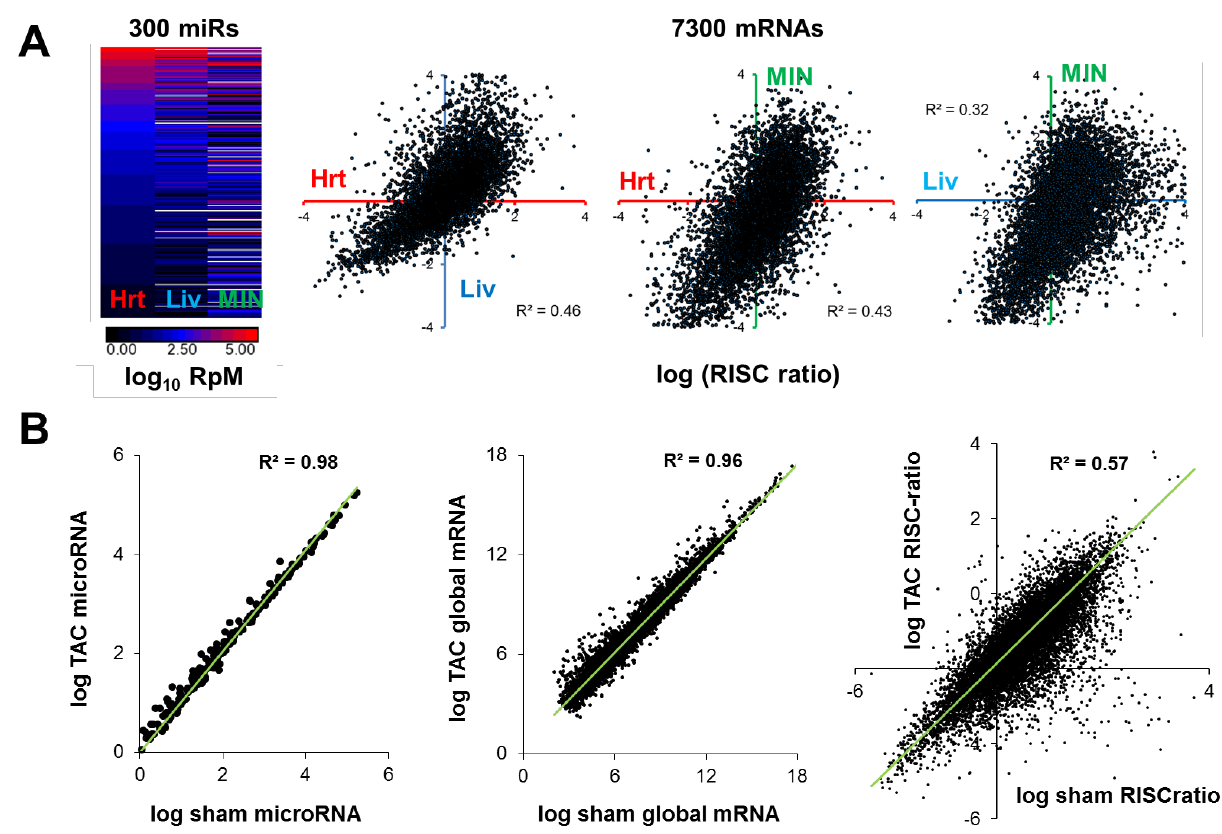
Figure 4. ( a ) Left , Heatmap displaying abundances of 300 microRNAs expressed in mouse heart, liver and MIN-6 cultured  -cells. Right , graphs of log (RISC ratio), where RISC ratio equals (RISC abundance / global mRNA abundance), for 7300 mRNAs expressed in common between heart (red), liver (blue) and  -cells (green). ( b ) Transcriptome-wide differences in microRNAs, global mRNAs, and mRNA RISC ratios in sham-operated and 1-week pressure-overloaded (TAC) mouse hearts. Data in ( b ) are redrawn from [34] and NCBI GEO accession